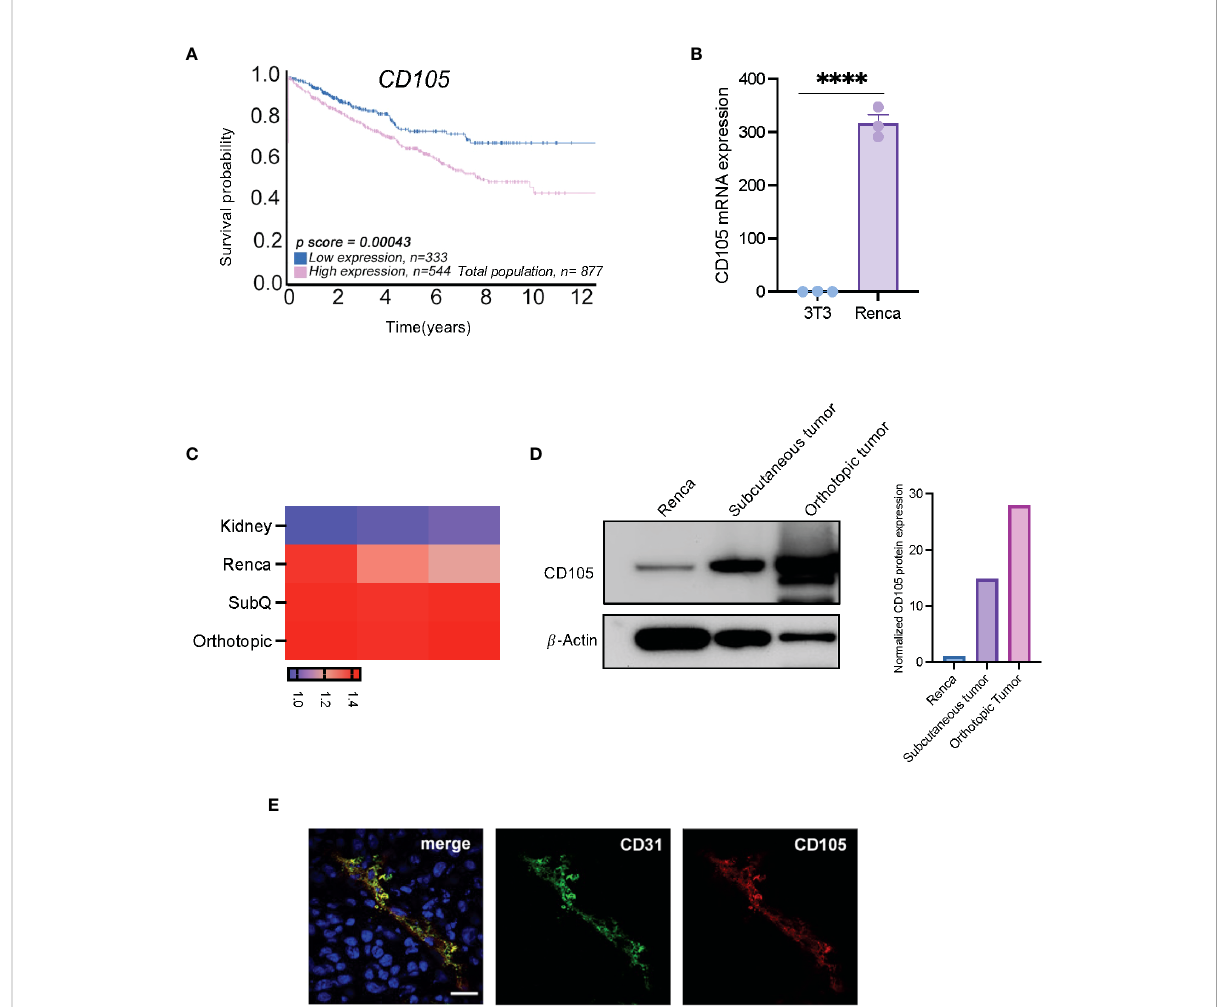
FIGURE 1 CD105 is highly expressed in RCC, and it correlates with a poor prognosis. (A) Overall survival probability of patients expressing a high level of CD105 as compared with those with lower CD105 expression, cutoff = 35.74 fragments per kilobase of transcript per million reads (FPKM). (B) mRNA expression of CD105 in NIH-3T3, and (C) Renca cell line, normal kidney, and in vivo generated tumors. (D) Protein expression of CD105 on Renca cells and tumors derived after subcutaneous and orthotopic implantation of Renca cells in male mice. (E) Immuno fl uorescence visualization of the expression of CD105 and CD31 by Renca tumor tissues **** P < 0.0001. error bar is shown as mean ±